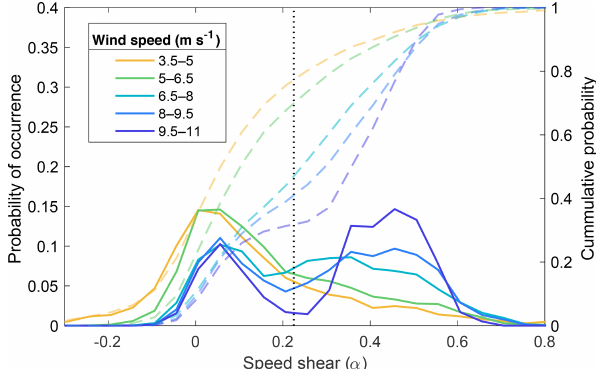
Figure 12. Speed shear probability density (solid lines) and cumu- lative (dashed lines) distributions for 1.5ms − 1 wind speed regimes. The black dotted line marks α = 0 .